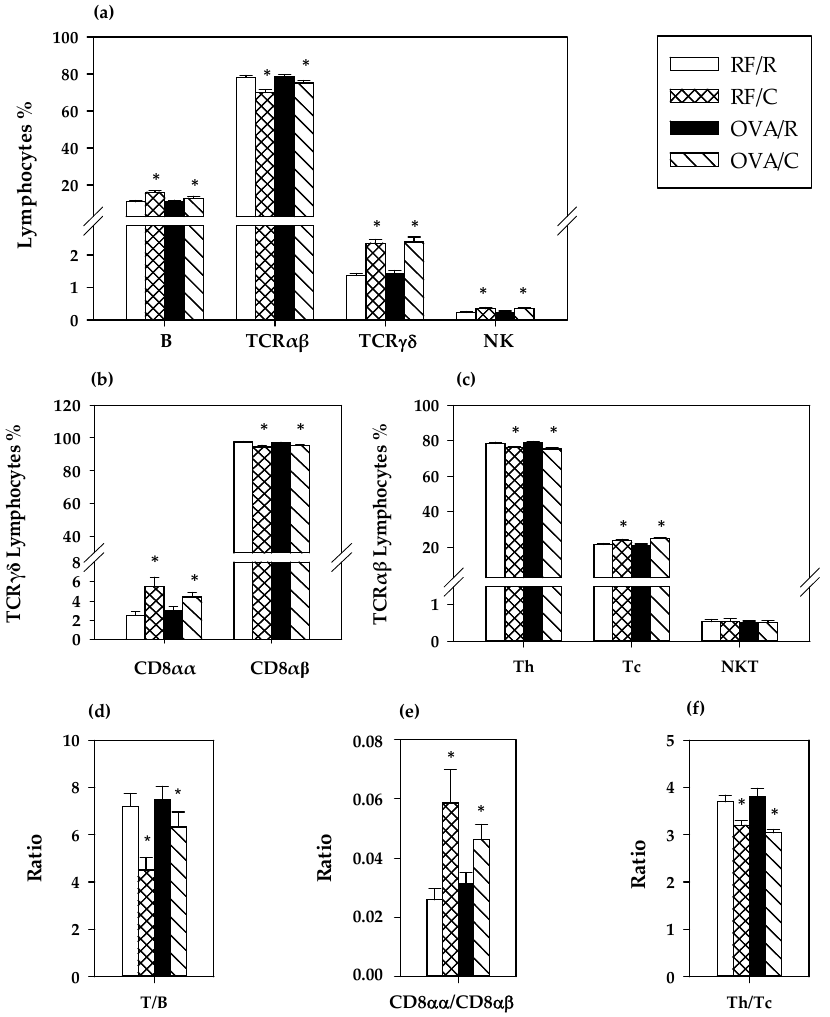
Figure 3. MLN lymphocyte composition. ( a ) Main lymphocyte subsets; ( b ) main TCR γδ + lymphocyte subsets; ( c ) main TCR αβ + cell subsets; ( d ) TCR αβ +/B lymphocytes ratio; ( e ) CD8 αα /CD8 αβ ratio in TCR γδ + cells; ( f )Th/Tc ratio in TCR αβ + cells. Values are expressed as mean ± standard error ( n = 9).